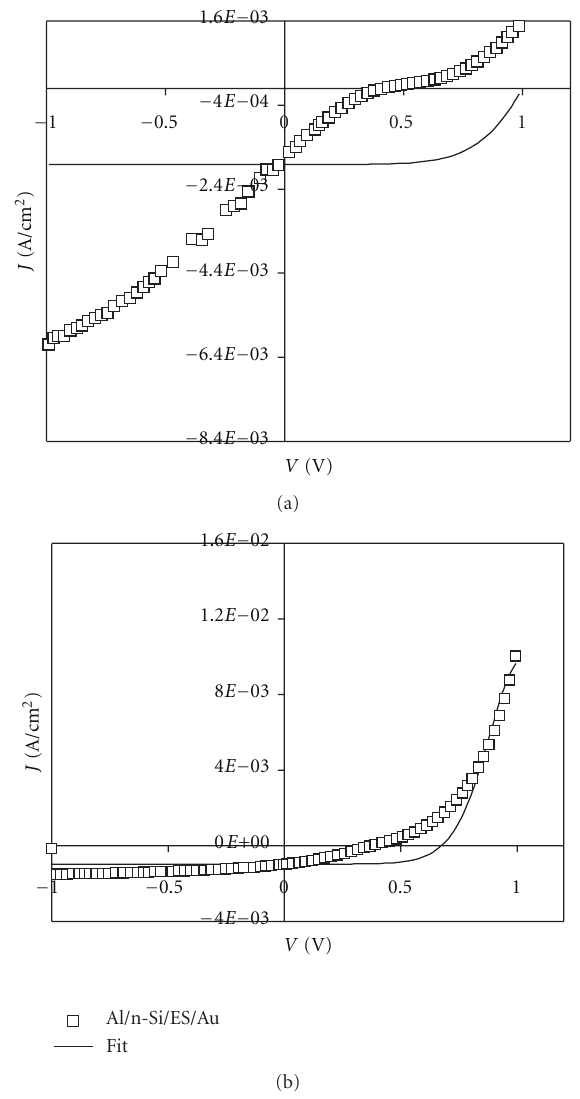
Figure 3: J - V characteristics for Al/PANI-DBSA/n-Si heterojunc- tions under illumination (0.09W/cm 2 ) using Au or Ag as Ohmic contact. The solid line represents the expected J - V behaviors.